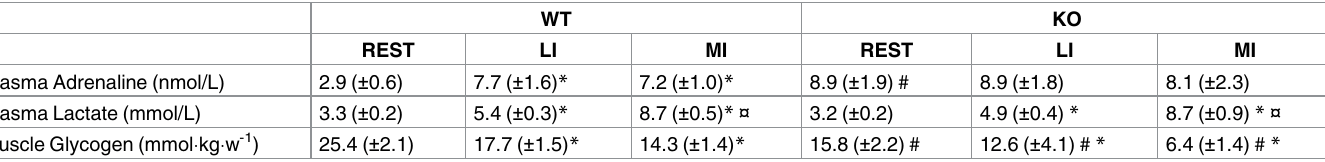
Table 2. Single treadmill exercisebout.